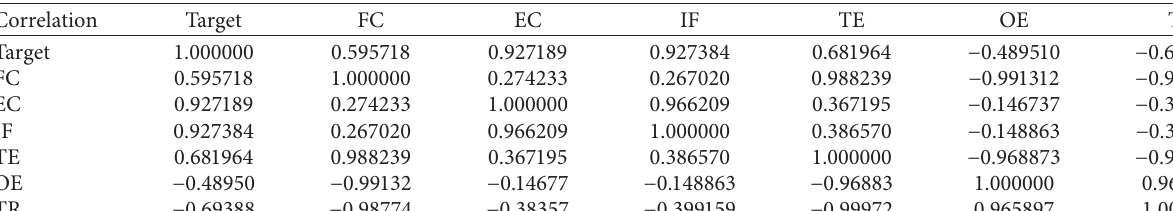
Table 6: Correlation coefficient table.